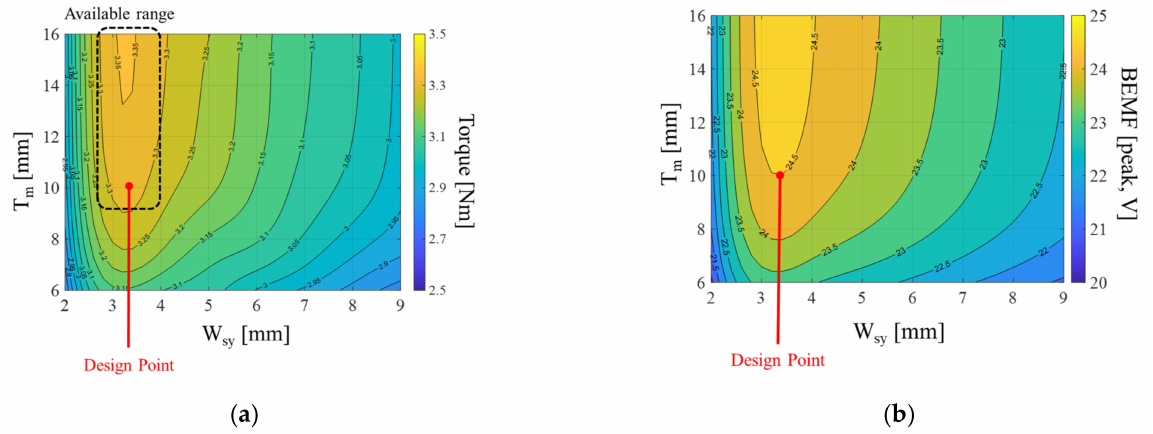
Figure 9. Characteristics for the design parameters: ( a ) torque; ( b ) BEMF.